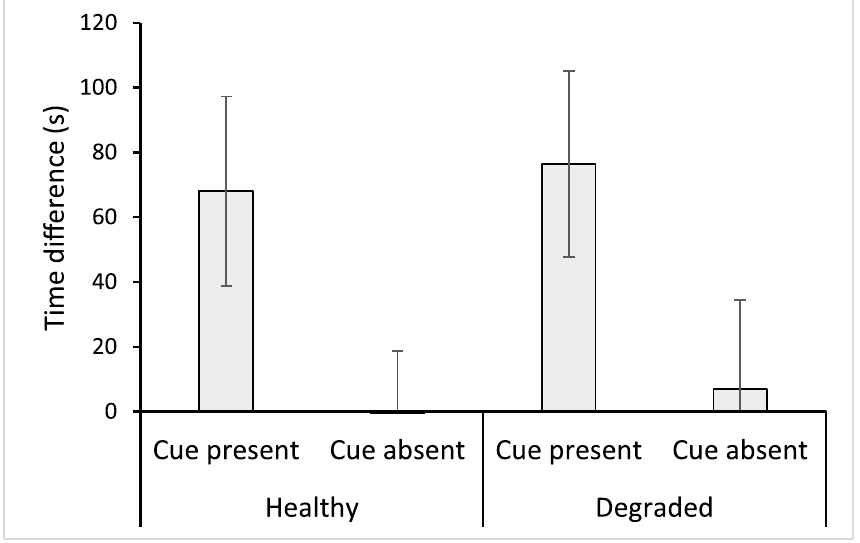
Fig 3. Predator response to prey damage odours, represented as a difference from controls. Mean difference ( ± SE) in time spent by Pseudochromis fuscus betweenchambers of y-mazes injected with damage-releasedodours from Pomacentrus amboinensis or seawater, when the damage-releasedodour was present or absent, againsta background of either healthy or dead-degraded coral treated seawater; n(left to right) 19, 16, 17,